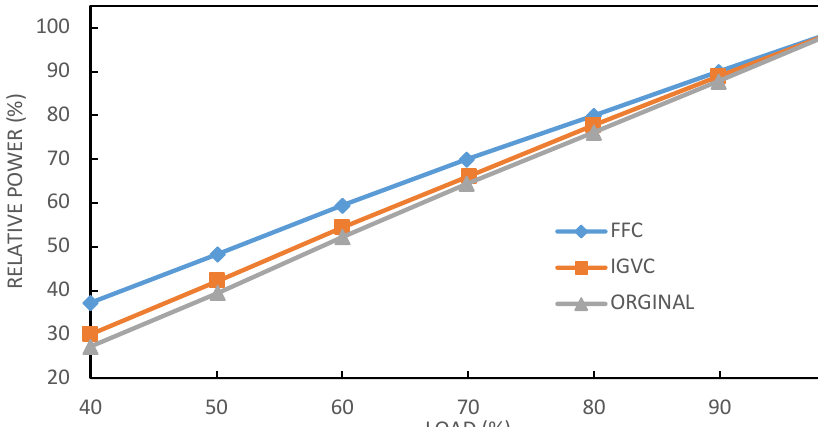
Figure 3. Relative power optimization diagram